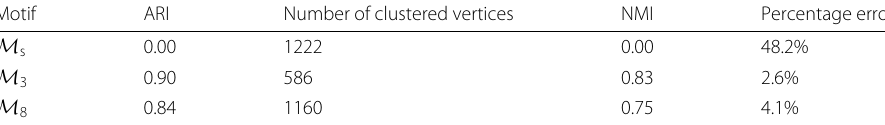
Table 1 Performance of motif-based clustering on the US-P OLITICAL -B LOGS network